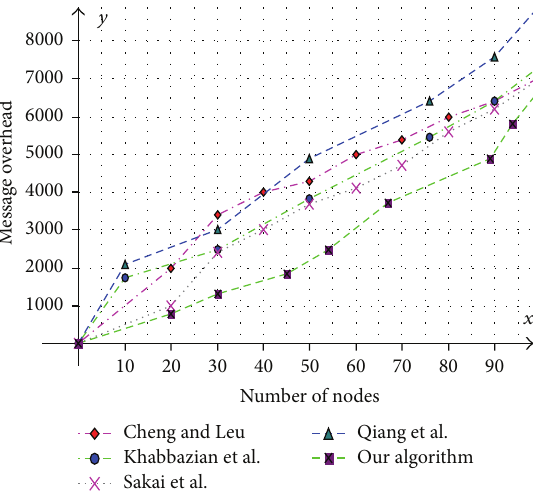
Figure 12: Number of nodes versus message overhead.